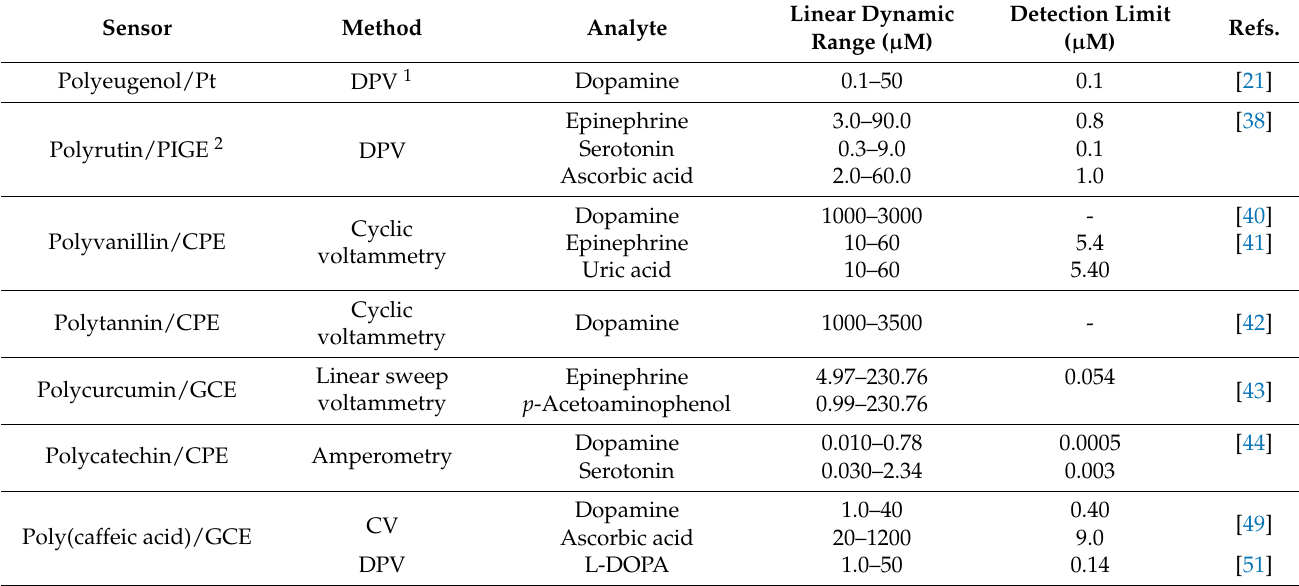
Table 2. Analytical characteristics of neuromediator determination using sensors based on the electropolymerized natural phenolic